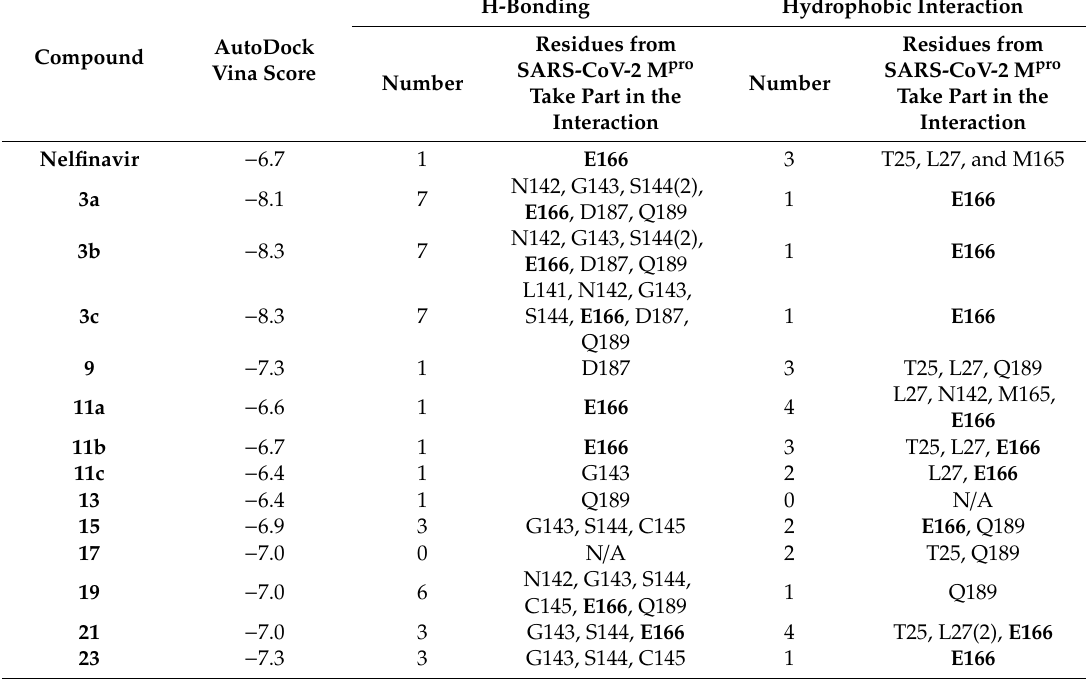
Table 1. The interaction pattern of the thiazole compounds ( 3a , 3b , 3c , 9 , 11a , 11b , 11c , 13 , 15 , 17 , 19 , 21 , and 23 ) and Nelfinavir against SARS-CoV-2 M pro . The AutoDock Vina scores are listed among the number of H-bonds and hydrophobic contacts and the residues that interact. Bold residues are the most interacting residue